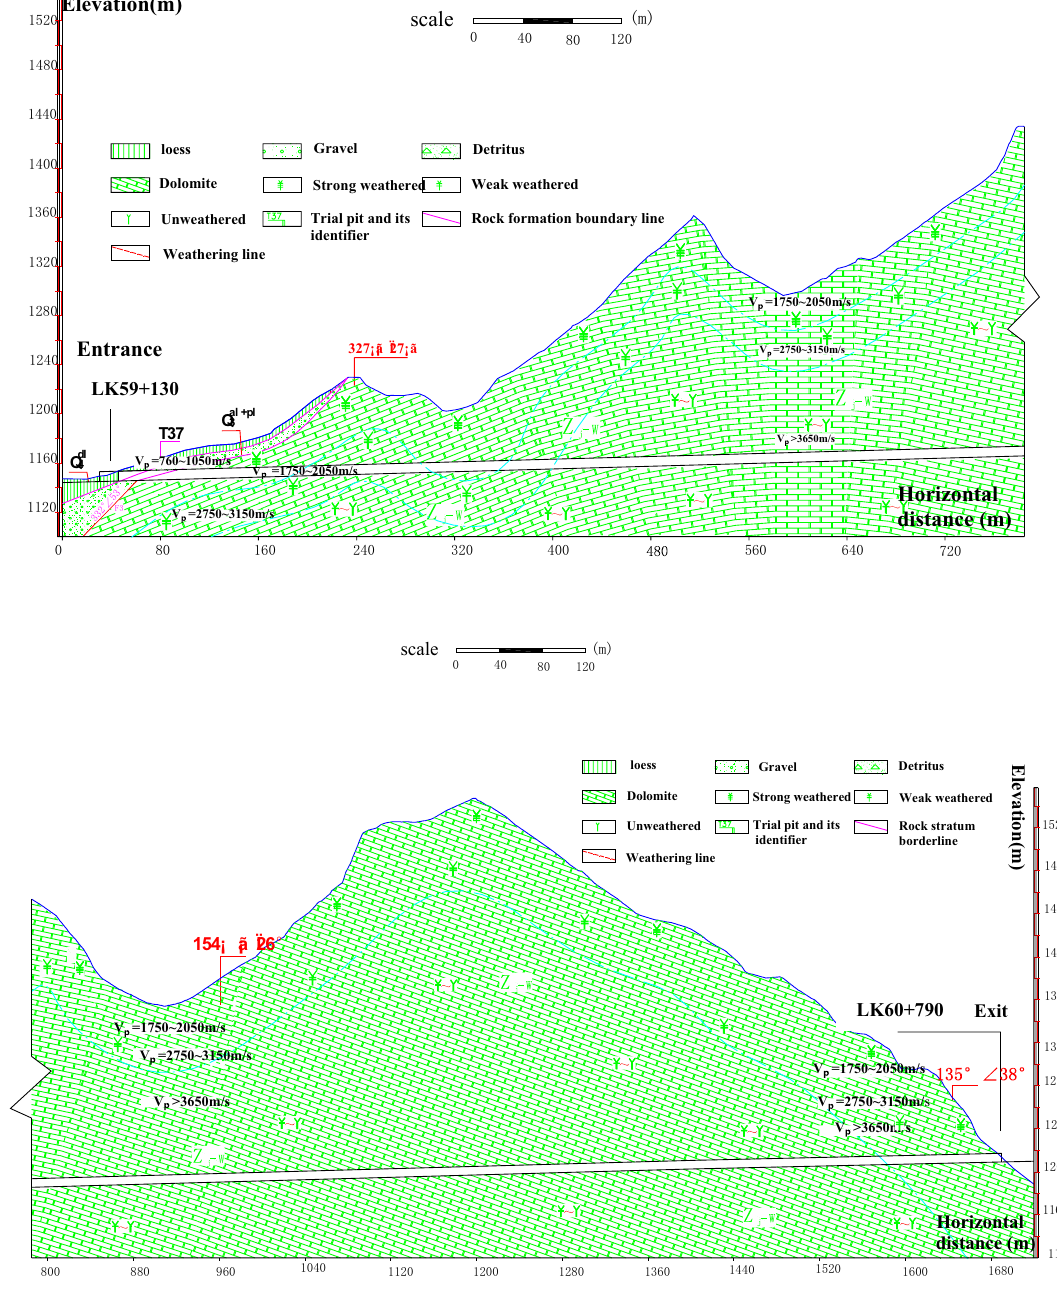
Figure 3. Geological profile of the left line of the Beikou